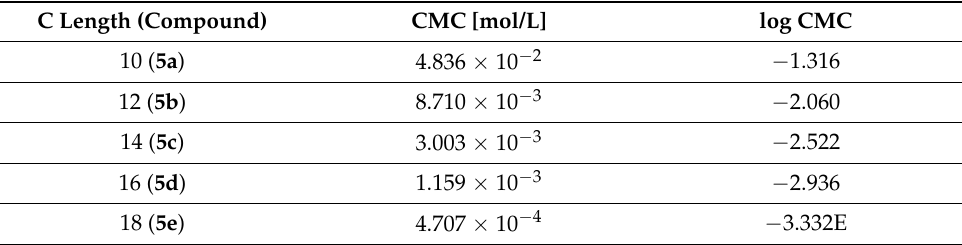
Figure 2. Dependency of log CMC on length of alkyl chain. Table 2. CMC value of compounds 5a-5e